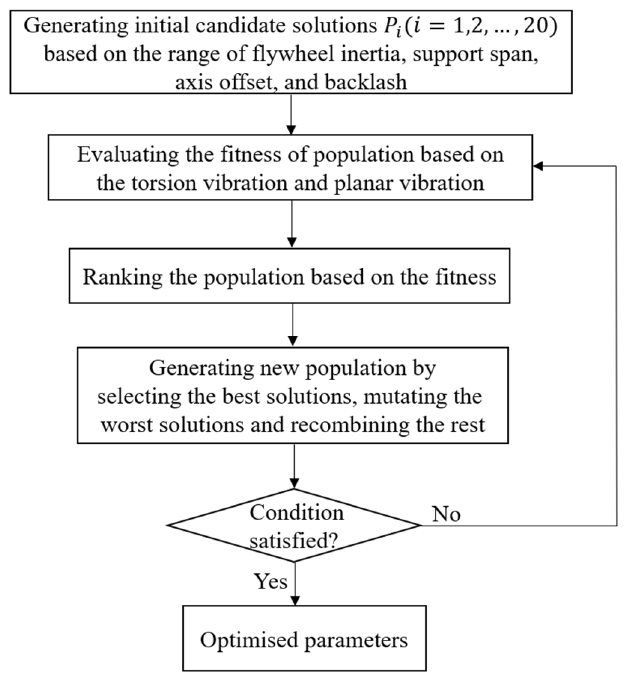
Figure 9. Program flow chart of the genetic algorithm.